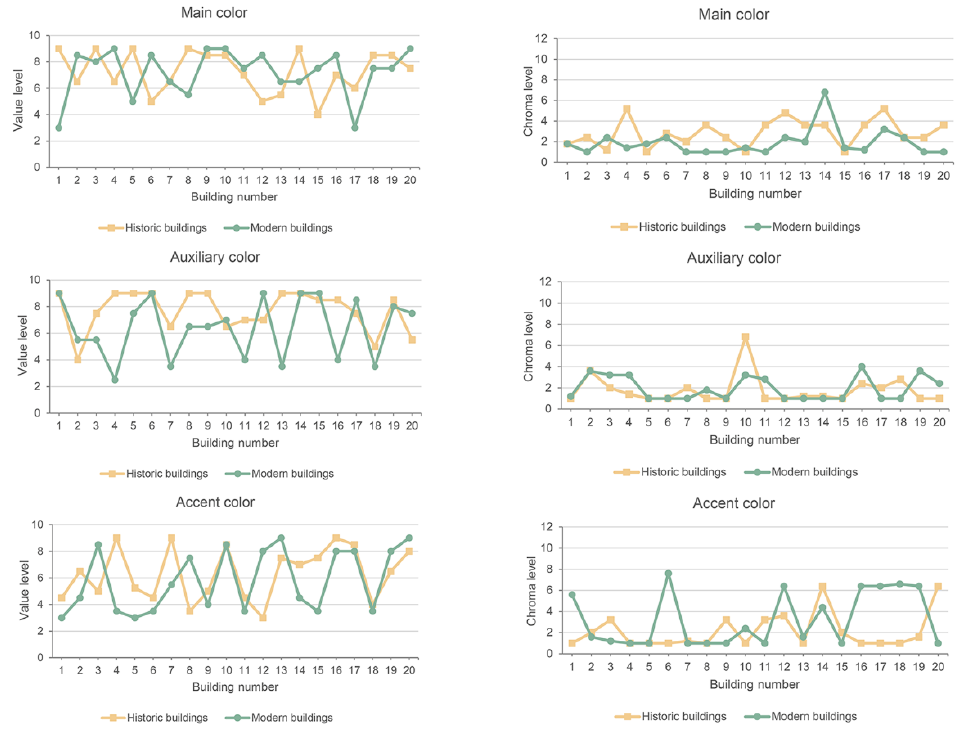
Figure 3. Comparison analysis of color brightness and purity between historical and modern build- ings.